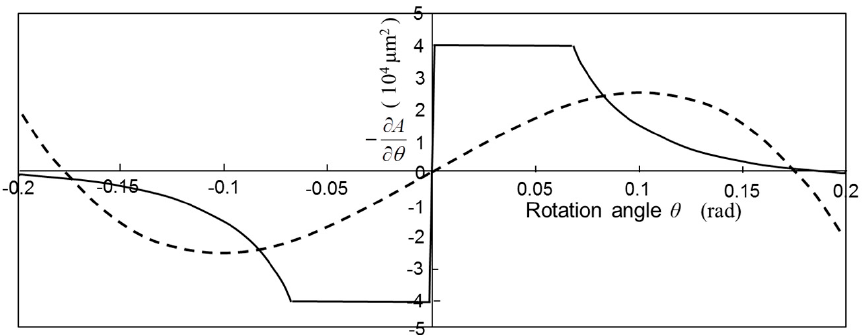
Figure 4. Derivation of the superposed area of comb fingers as a function of rotation angle (solid curve) and the curve by the least-square method (dotted curve).